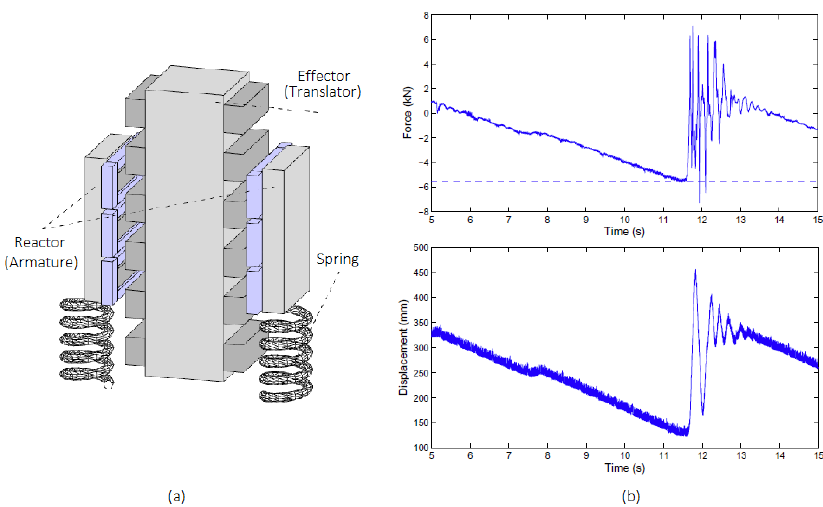
Figure 26. Conceptual design of the Snapper ( a ) [130], generously provided by Richard Crozier,